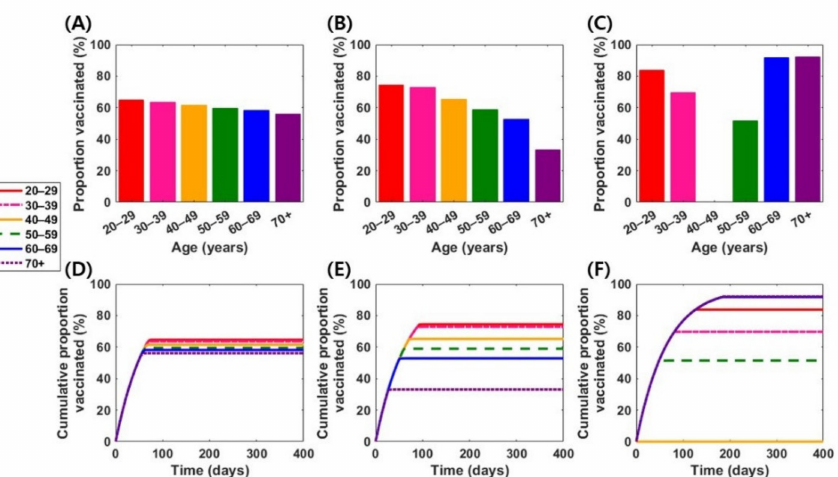
Figure 3. Optimal vaccination strategies in various vaccine scenarios when vaccines provide 95% of reduction in the risk of disease per exposure. The first row represents age-specific levels of optimal vaccination coverage in the vaccine 4 ( A ), vaccine 5 ( B ), and vaccine 6 ( C ) scenarios. The second row represents time-dependent cumulative vaccination coverage levels under optimal vaccination schemes in the vaccine 4 ( D ), vaccine 5 ( E ), and vaccine 6 ( F )